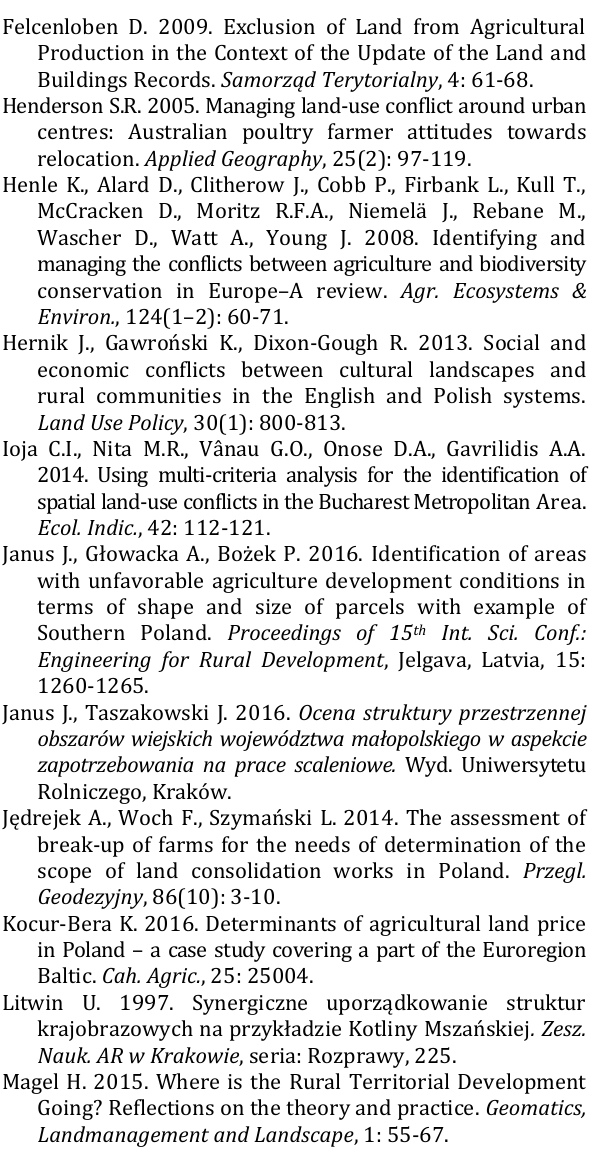
Fig. 6. Classification of the socio-spatial conflicts (source: own